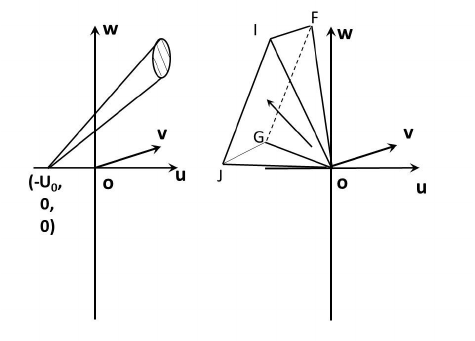
Figure 12. Velocity phases for the problem of a round jet impinging on a diffuse reflective plate. Left : for the free jet; Right for the reflected